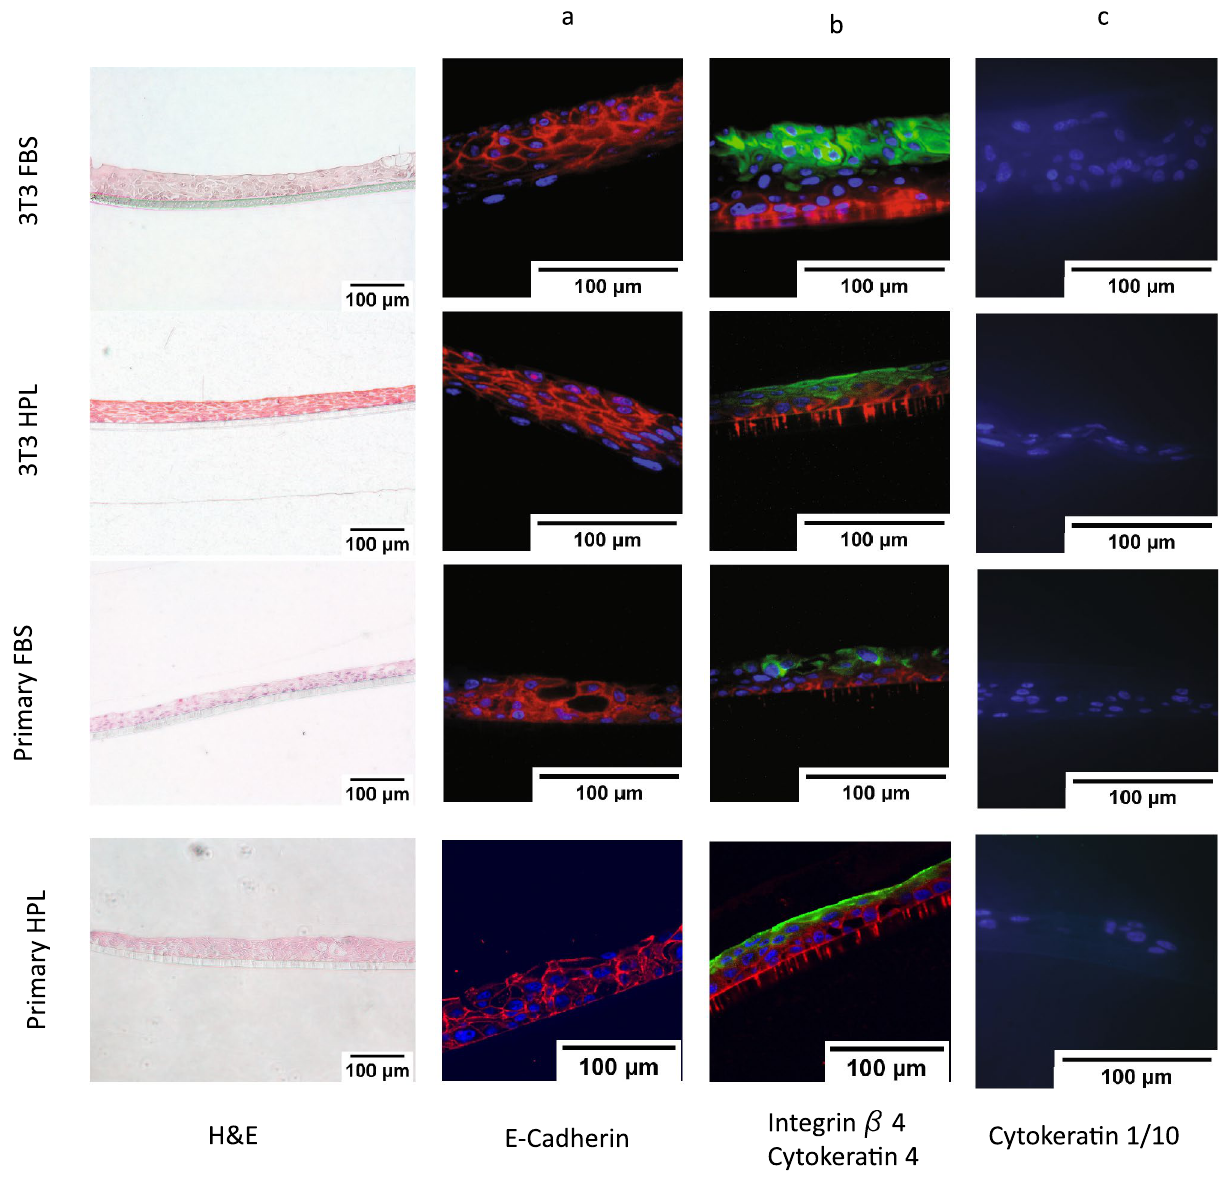
Figure 5. Immunofluorescent staining of the ALI cultures. Representative images for H &E, E-cadherin (red) ( a ) or integrin B4 (red) and cytokeratin 4 (green) ( b ) and Cytokeratin 1/10 (green) ( c ) for the 4 conditions 3T3 FBS Y-27632 (1st row), 3T3 HPL Y-27632 (2nd row), Primary FBS Y-27632 (3rd row), Primary HPL Y-27632 (4th row), Nuclei stained by DAPI (blue) Scale bar shows 100 µm, n =